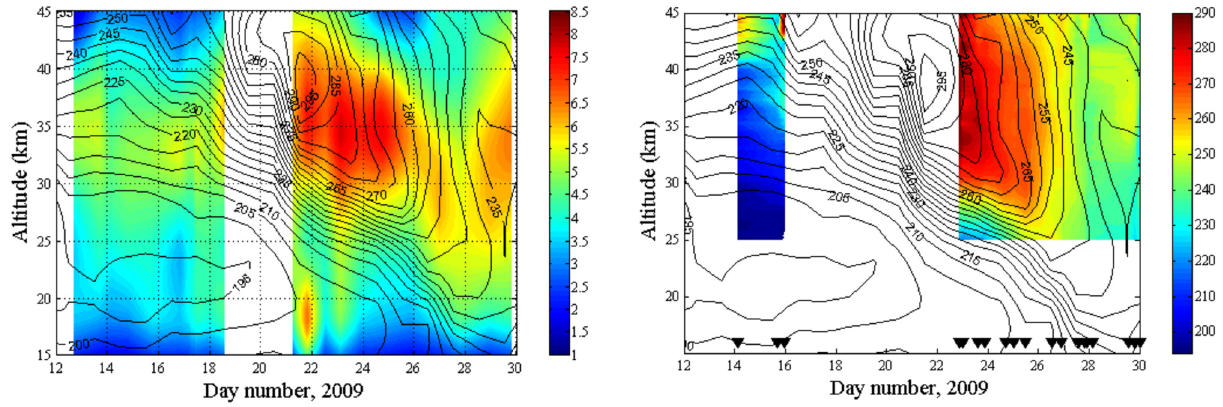
vmr (in color, units of ppmv). Solid black contour lines depict temperature measurements Figure 15 (left panel). Contour map of GBMS O 3 obtained with the satellite-based Aura MLS instrument. Figure 16 (right panel). Contour map of temperature values (in units of K) obtained from lidar measurements (in color). Solid black contour lines depict temperature measurements obtained with the satellite-based Aura MLS instrument. Solid black triangles at the base of the plot show when lidar measurements were carried